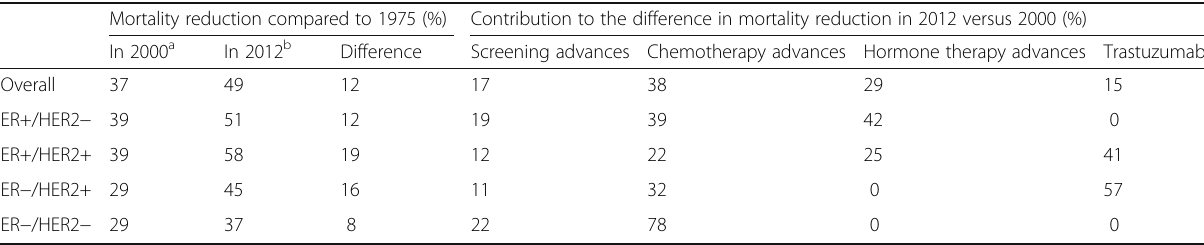
Table 1 Association of screening and treatment with breast cancer mortality in US women from 2000 to 2012 Mortality reduction compared to 1975 (%) Contribution to the difference in mortality reduction in 2012 versus 2000